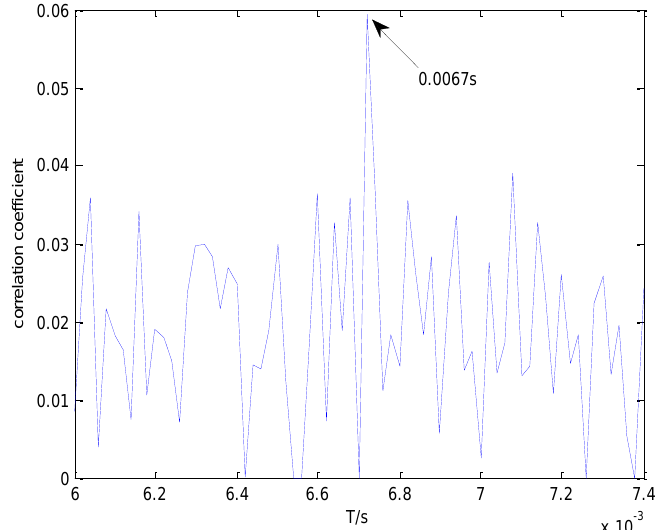
Figure 13. Maximal correlation coefficients for different elements from set T using the conventional method.